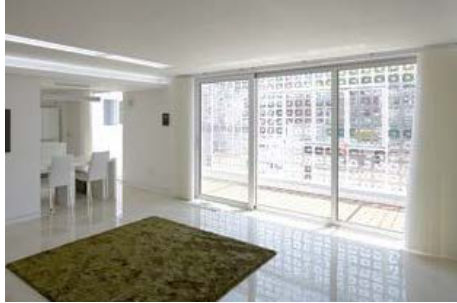
Fig 9(d) Screening on bedroom gives privacy & controls sunlight Fig 9(e) Screening on the